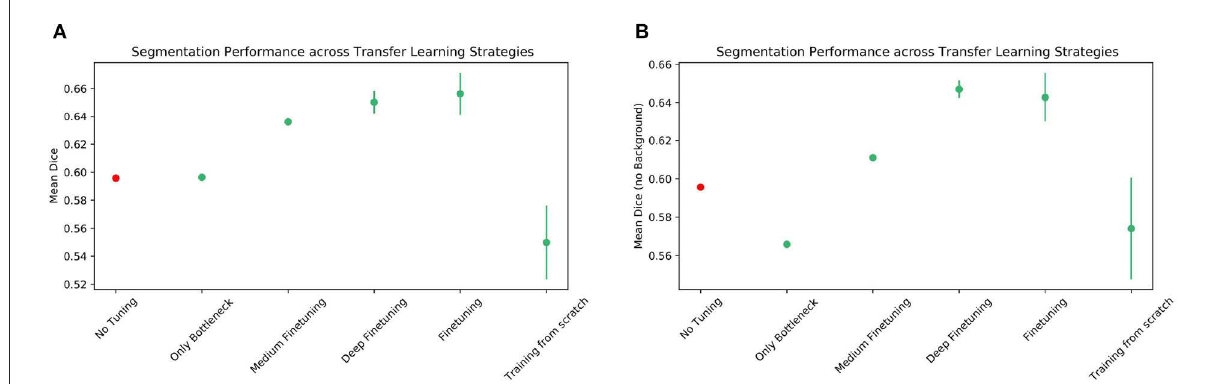
FIGURE11 re contains two plots detailing the segmentation performance, averaged over four runs each, of the transfer learning strategies presented. (A) shows the mean DSC across all classes, while in (B) background classes are excluded. Added error bars of length “standard deviation” mark the variability of the scores. The condition No Tuning is marked in a different color to emphasize that only one run was tested.